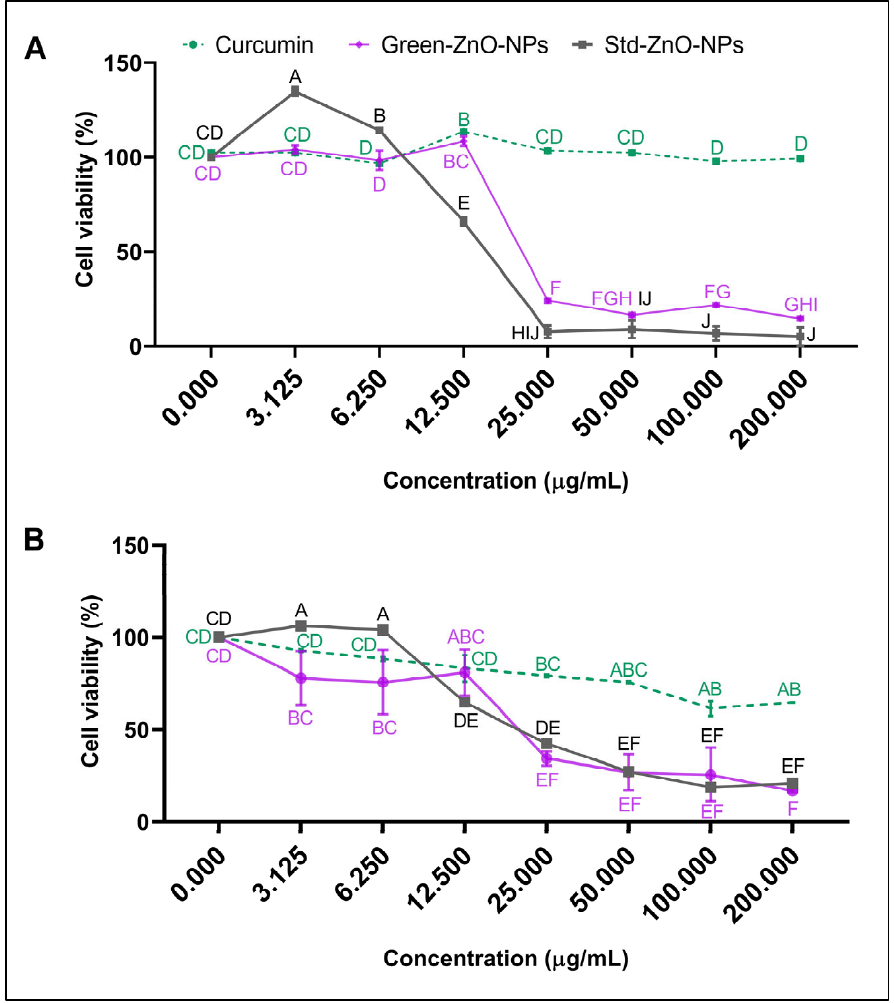
Figure 9. Anticancer activity of Std-ZnO-NPs, Green-ZnO-NPs and curcumin against MCF-7 human breast cancer cells after ( A ) 24 h and ( B ) 48 h of exposure. Tukey post hoc multiple comparison tests show a significant difference ( p < 0.05) between samples with different letters (mean ± SD; n = 3).